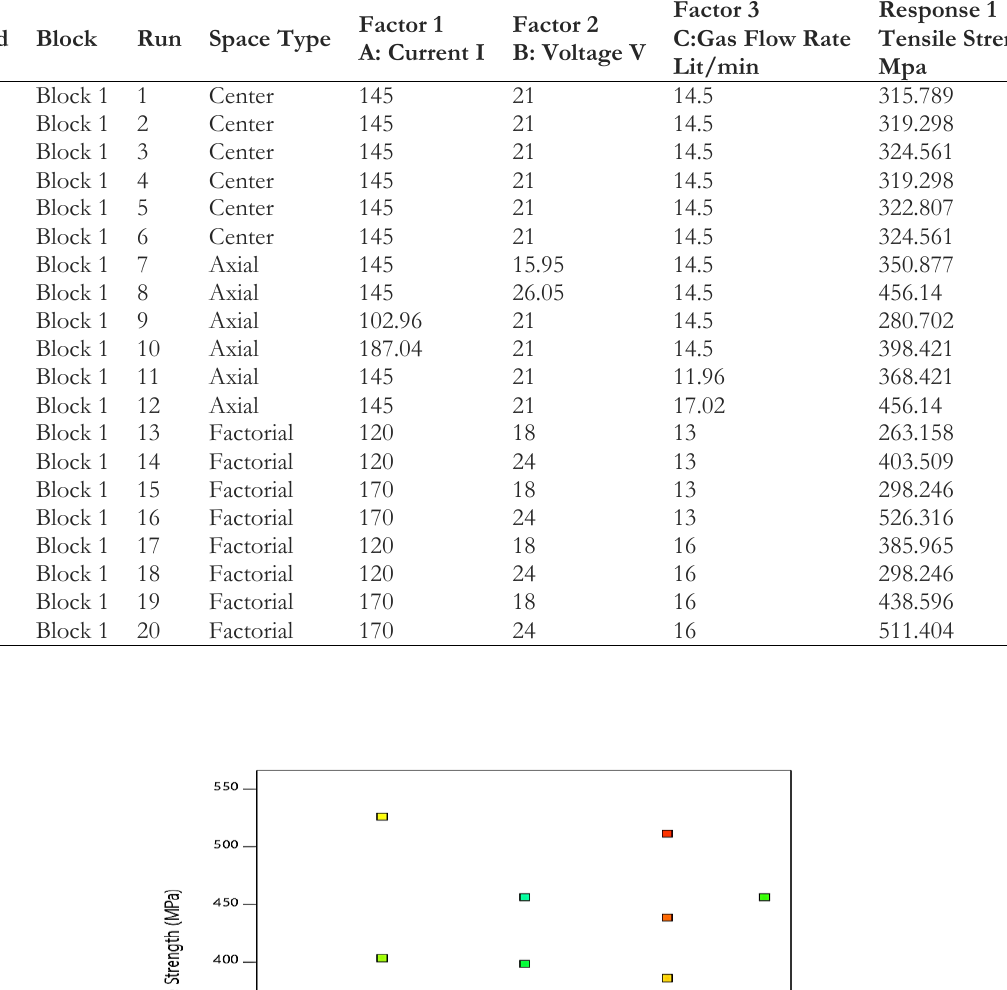
Table 2. Design matrix showing the real values and the experimental values.